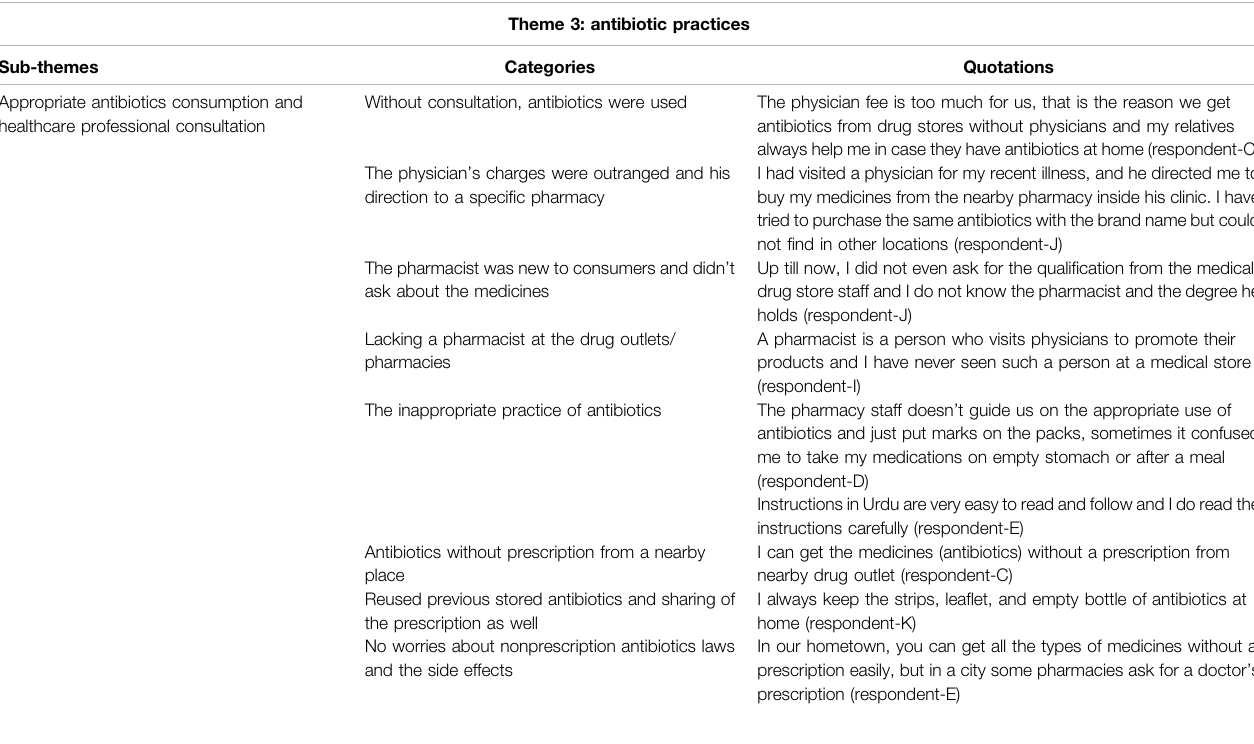
TABLE 5 | Participants ’ practice toward antibiotics.